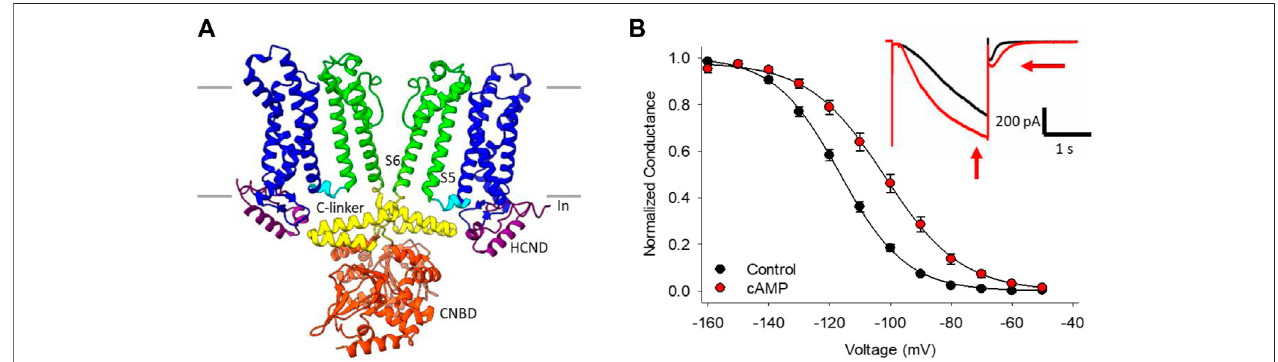
FIGURE 1 | HCN channel structure, currents and regulation by cAMP. (A) CryoEM structure of HCN4 showing only two of the four subunits for clarity (PDB ID: 6YGO). The six transmembrane-spanning domains in each subunit form the voltage sensing domain (S1-S4, blue ) and the pore domain (S5-S6, green ). The C-linker ( yellow ) and cyclic nucleotide binding domain (CNBD, orange ) in the C-terminus mediate the response to cyclic nucleotides. (B) Conductance-voltage relationships for HCN4 channels in the absence ( black ) or presence ( red ) of cAMP. Hyperpolarization-activated currents recorded from a HEK cell expressing HCN4 before ( black ) and after ( red ) perfusion of 100 µM cAMP ( inset ).